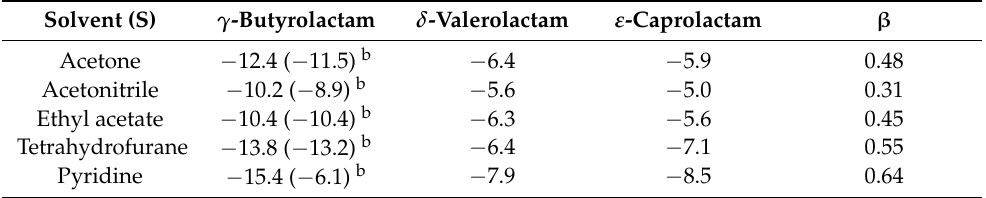
Table 3. Hydrogen bonding enthalpies of γ -butyrolactam, δ -valerolactam and ε -caprolactam in